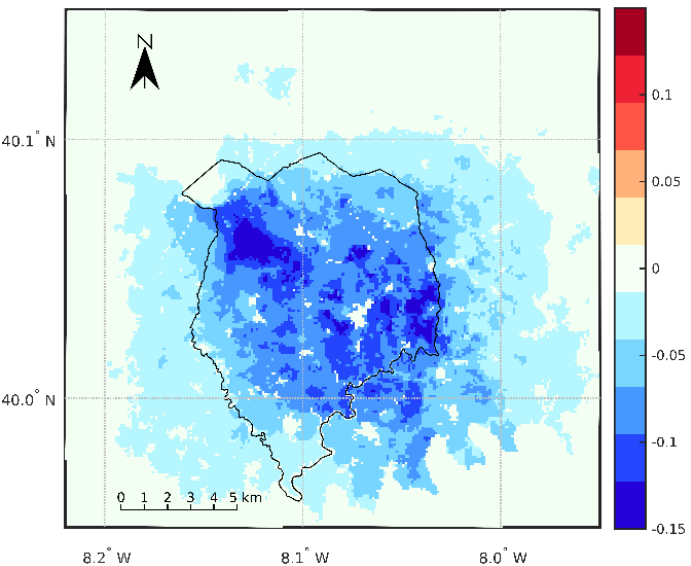
Figure 8. Impact of integrating fuel uncertainty in the spatial distribution of estimated burn probability. The color bar shows the difference in burn probability calculated as: “with uncertainty” − “without uncertainty”.